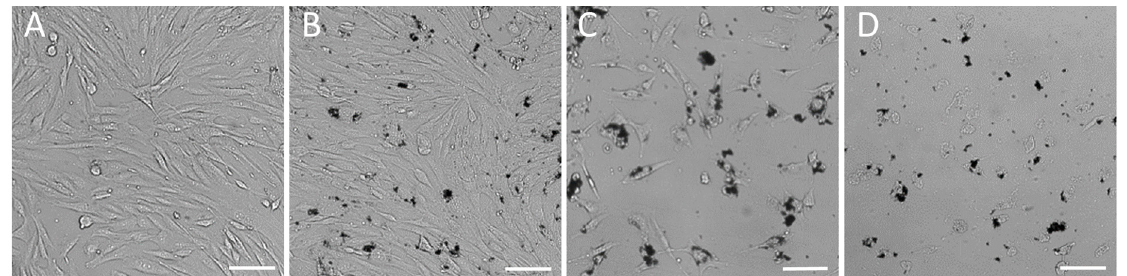
Figure 2. Influence of SAMN-R in different doses to mouse embryonic fibroblast cells (3T3) morphology. ( A ) Control; ( B ) dose of SAMN-R 20 µ g · cm − 2 ; ( C ) dose of SAMN-R 25 µ g · cm − 2 ; ( D ) dose of SAMN-R 35 µ g · cm − 2 . Bright-field microscopy, 10 × magnification, scale bar 100 µm.